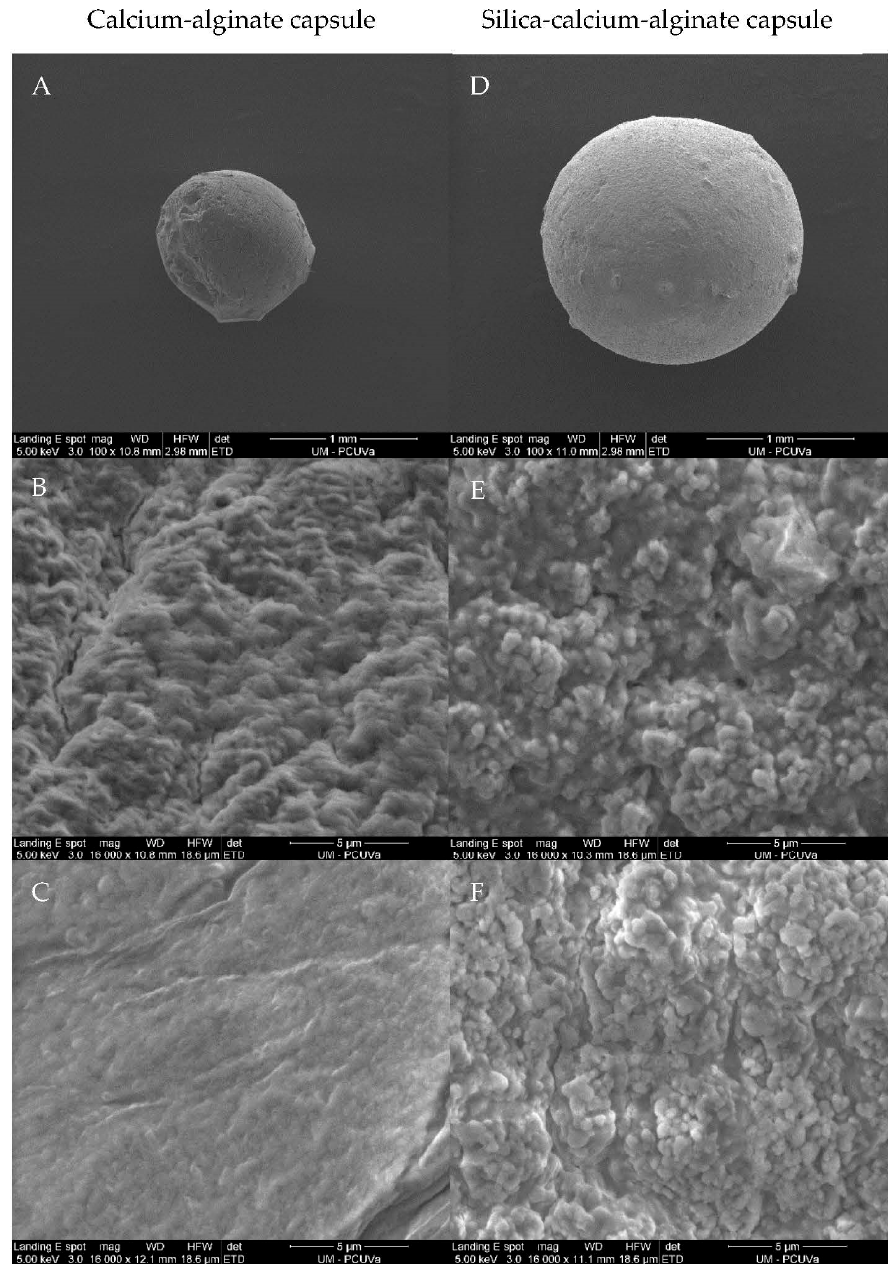
Figure 2. Scanning electron microscopy micrographs of external ( A , B , D , E ) and internal ( C , F ) surfaces of calcium-alginate ( A – C ) and silica-calcium-alginate ( D – F ) capsules. The elemental analysis of calcium-alginate and silica-calcium-alginate capsules was carried out by X-ray spectroscopy. Figure 3A shows that the element peaks of the calcium- alginate capsule included carbon, oxygen, sodium, chloride and calcium. Chloride and calcium elements were from the calcium chloride solution used for the gelation of sodium alginate, and carbon, oxygen, and sodium from the chemical composition of the sodium alginate. The element peaks of the silica-calcium-alginate capsule (Figure 3B) included carbon, oxygen, sodium, silicon, chlorine and calcium. The peak of silicon veri fi ed the presence of SiO 2 in this capsule from colloidal silica and sodium silicate. The highest rel- ative number of atoms was observed for the silicon atom (24.53%), indicating that the